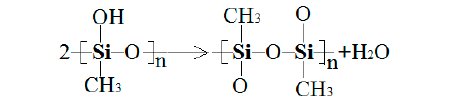
Scheme 2. Oxidation reaction of silicone under high moisture conditions.